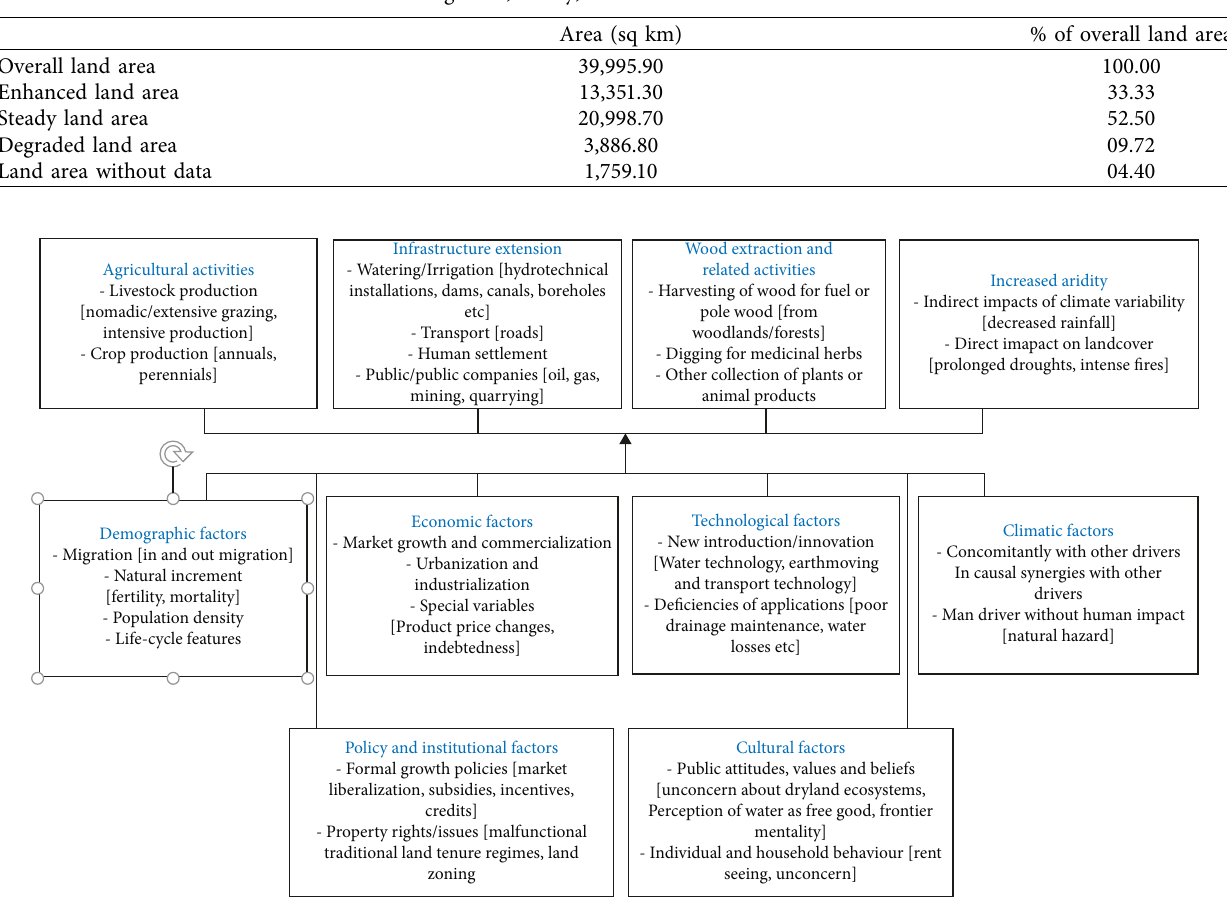
Table 1: Information on degraded, steady, and enhanced land areas between 2001 and